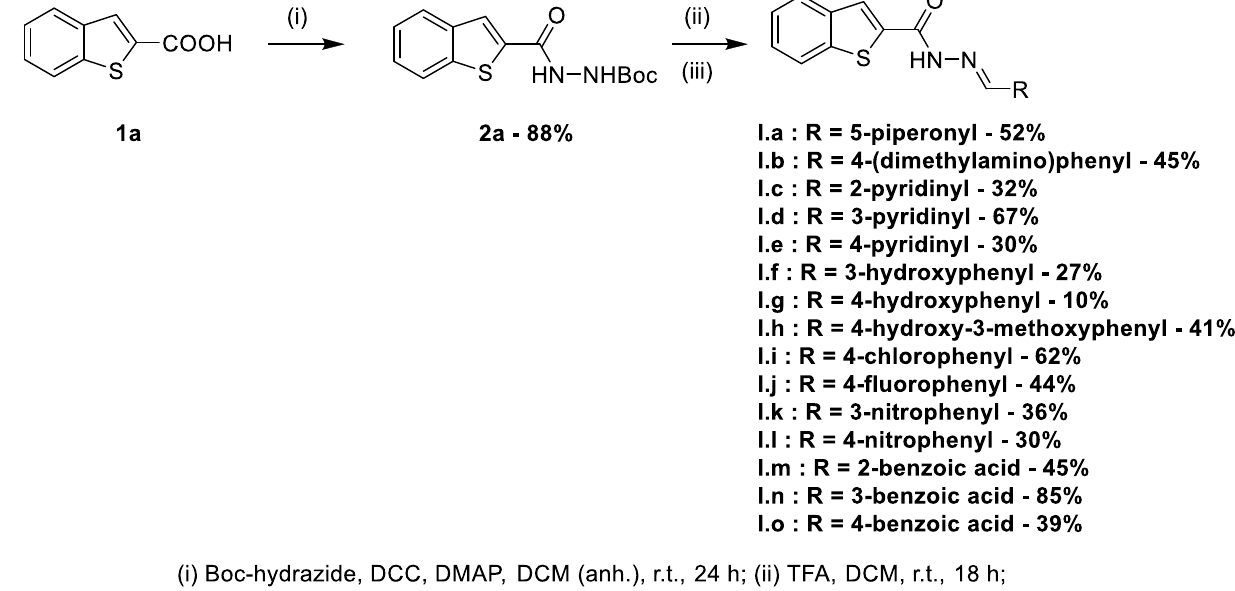
Scheme 1. Synthesis of set I